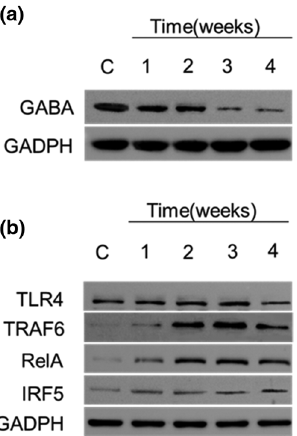
Figure 1: The TLR4/TRAF6/NF - kB signaling pathway in status epi - lepticus rats. Notes: ( a ) GABA and GAPDH levels in status epilep - ticus rats. ( b ) Western blot of rat brain revealed that the increased expression of TLR4, TRAF6, IRF5, and RelA post SE